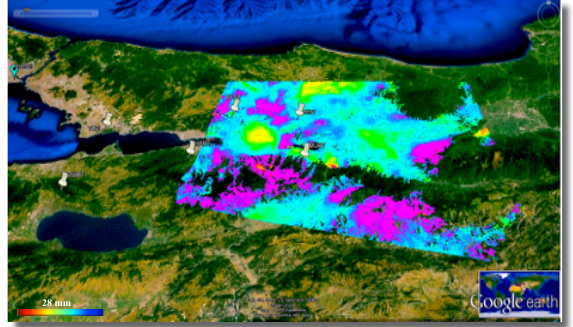
Figure 2: Mosaic unwrapped phases derived from ERS-1 and ERS-2 data displayed over a Google Earth image, from data derived from descending orbits on 10 th and 11 th September. The colour code indicates the phase differences caused by surface changes. BEST, DUMT HAMT, MURT, TUBI and UCGT stations have been marked on the map.